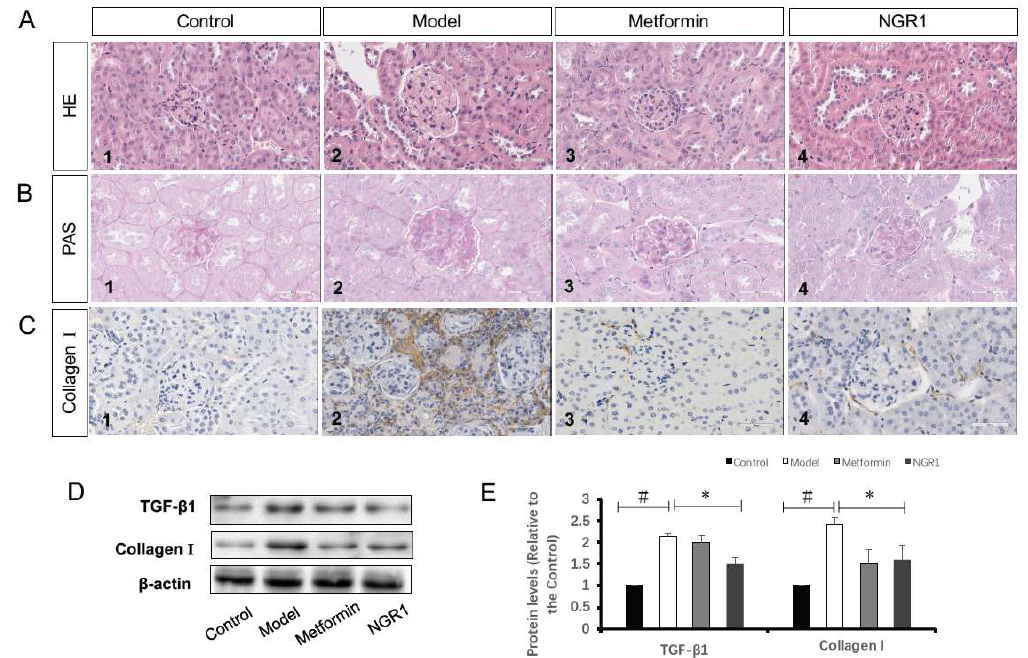
Figure 4. NGR1 attenuated histopathological changes via inhibition of transforming growth factor beta (TGF-β1)-mediated collagen I expression. Representative images of hematoxylin and eosin (H&E) staining ( A ) and periodic acid–Schiff base (PAS) staining ( B ) for pathological structure of kidneys in db / db mice (magnification: 400×); ( C ) representative images of collagen I determined by immunohistochemistry (ICH) staining (magnification: 400×); ( D ) representative images of TGF-β1 and collagen I protein expression determined by Western blot in the kidneys of each group; ( E ) relative protein expressions of TGF-β1 to β-actin, and collagen I to β-actin are expressed in the bar graphs. All data are presented as the mean ± SD ( n = 3). # p < 0.05 vs. the control group; * p < 0.05